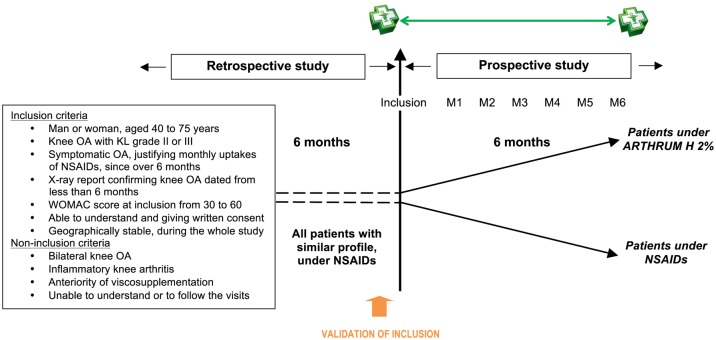
Study design.Patients with knee osteoarthritis were retrospectively assessed during 6 months at inclusion visit and prospectively during the next 6 months (one visit each month).